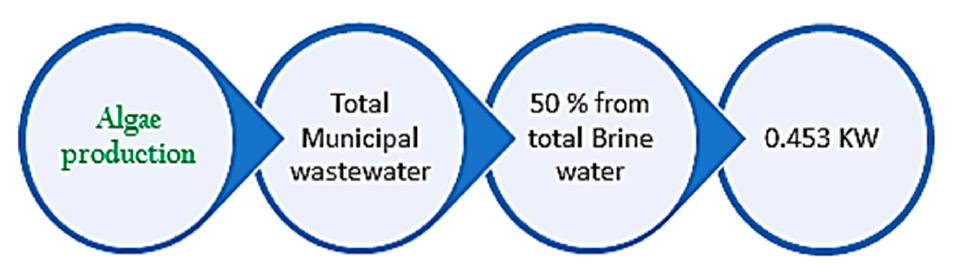
Figure 8. Algae production and total energy recovery in WD valley.